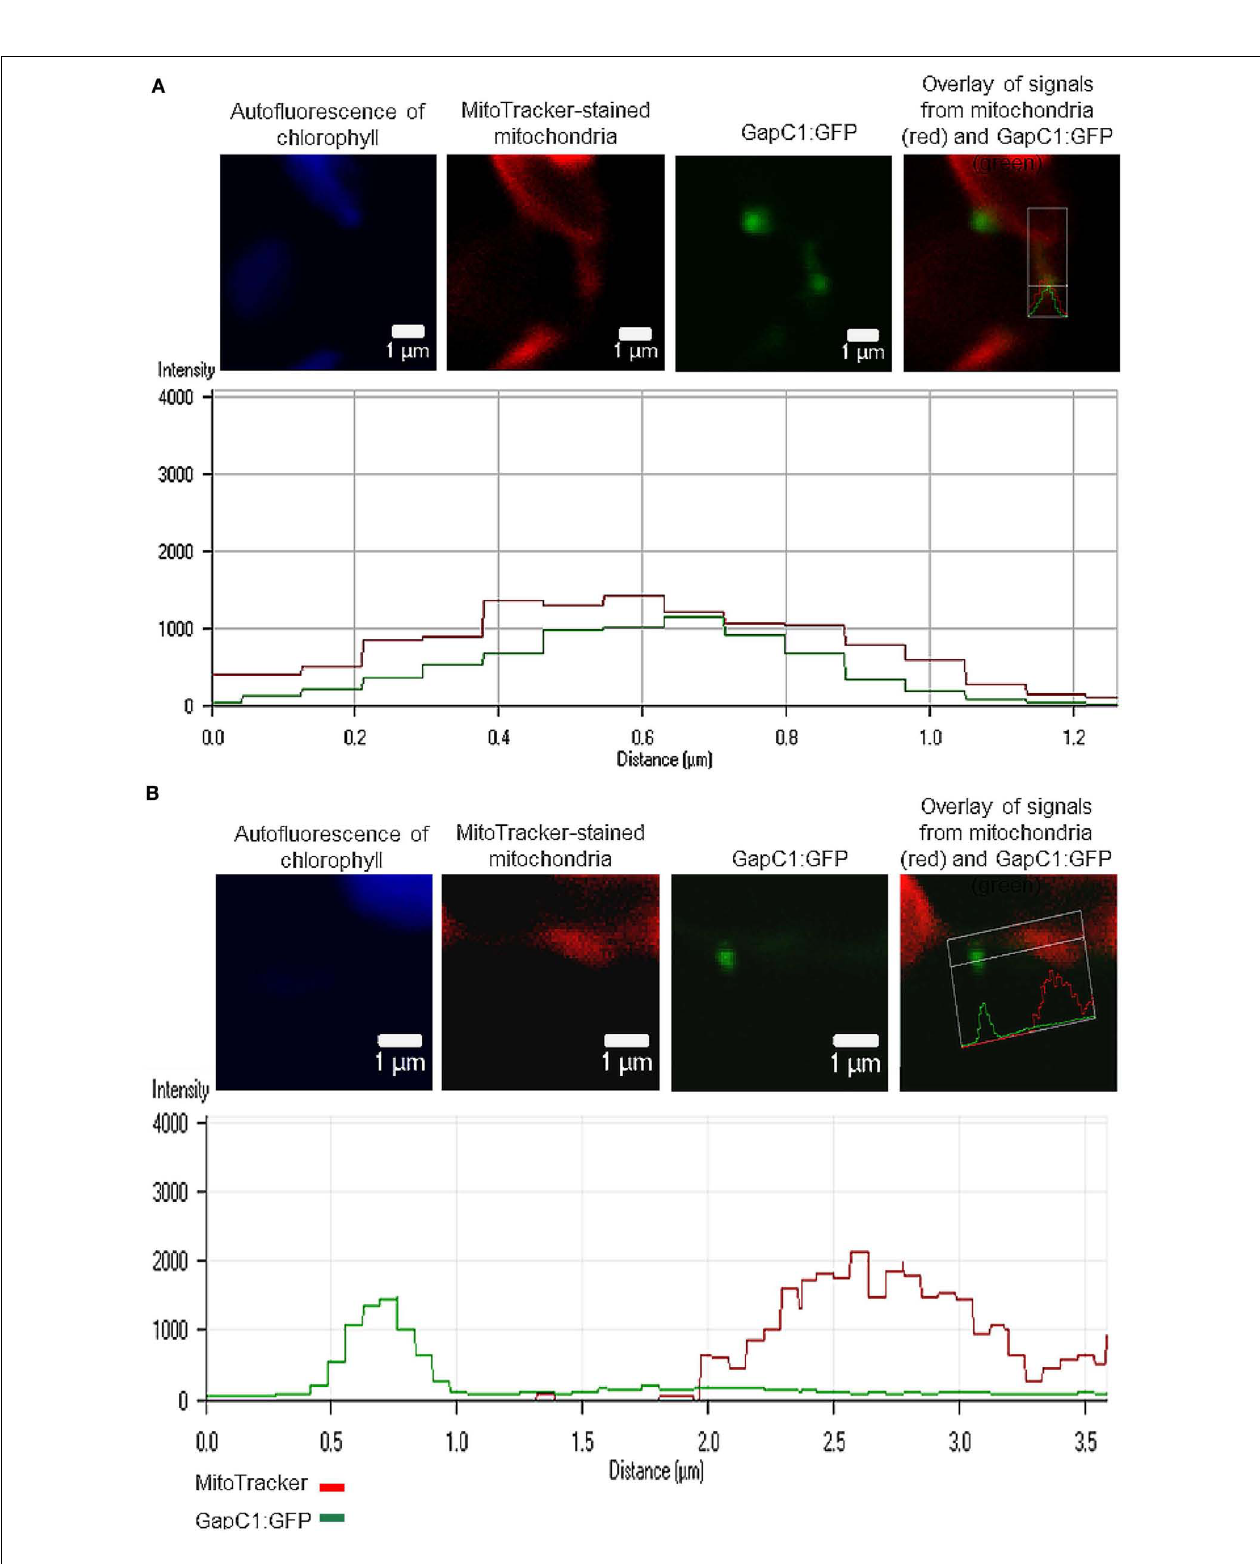
were magnified in order to perform a colocalization analysis by means of a fluorescence-intensity profile. One ROI displays a possible association of the glycolytic enzyme with mitochondrion (A) , whereas the other ROI shows no mitochondria association at the moment of visualization (B)